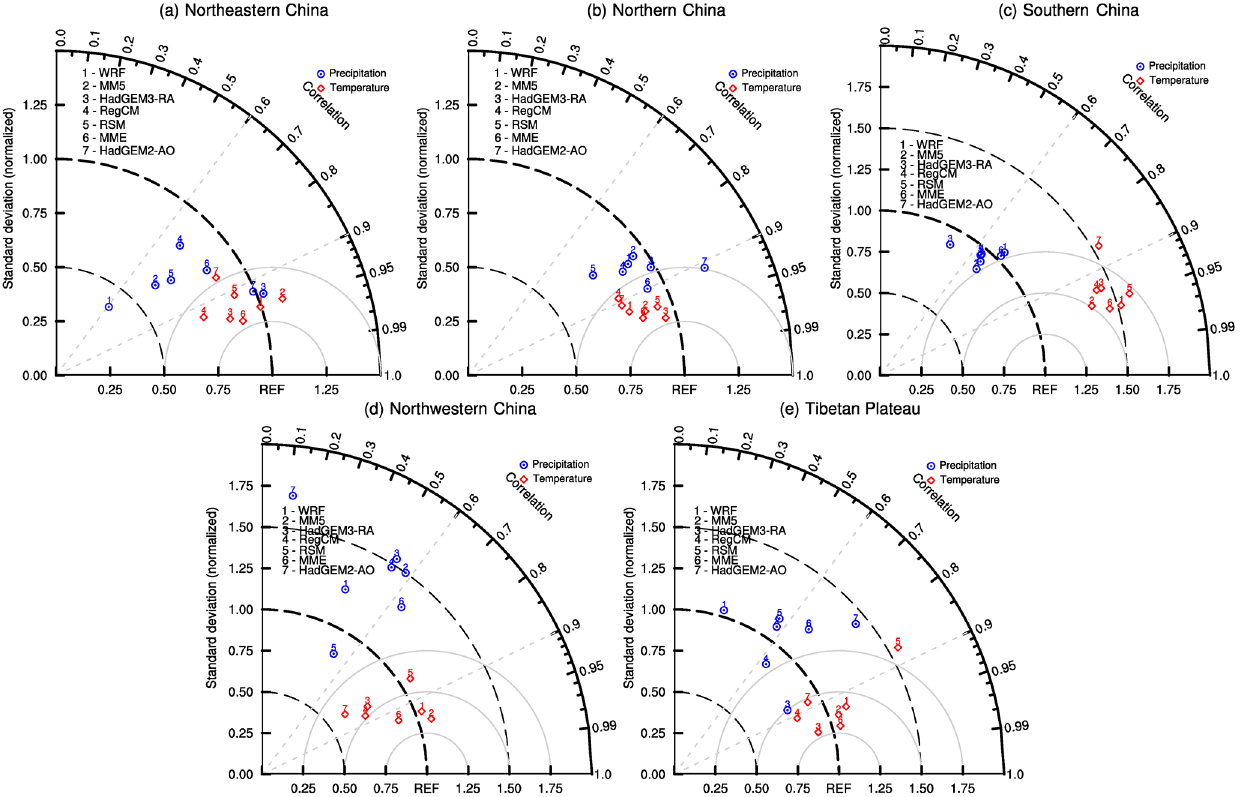
Figure 4. The Taylor diagrams which evaluate the skill of the models in reproducing the annual average temperature and precipitation over the five regions of China, using the CRU (for temperature) and APHRO (for precipitation) data as the reference, are shown. The azimuthal axis shows the pattern spatial correlation. The redial distance from the origin represents the spatial variability, whereas the distance from the reference observation (REF) is the centered RMSE difference between the simulations and